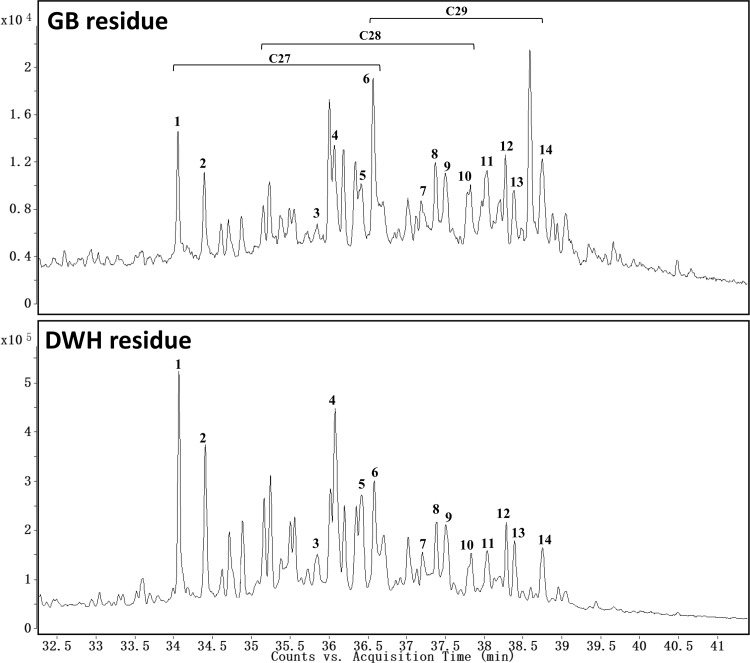
Comparison of extracted ion chromatograms of steranes (m/z of 217) for Galveston Bay and Deepwater Horizon oil spill residues [Peak 1: DiaC27βα(S); Peak 2: DiaC27βα(R); Peak 3: C27ααα(S); Peak 4: C27αββ(R); Peak 5: C27αββ(S); Peak 6: C27ααα(R); Peak 7: C28ααα(S); Peak 8: C28αββ(R); Peak 9: C28αββ(S); Peak 10: C28ααα(R); Peak 11: C29ααα(S); Peak 12: C29αββ(R); Peak 13: C29αββ(S); Peak 14: C29ααα(R)].